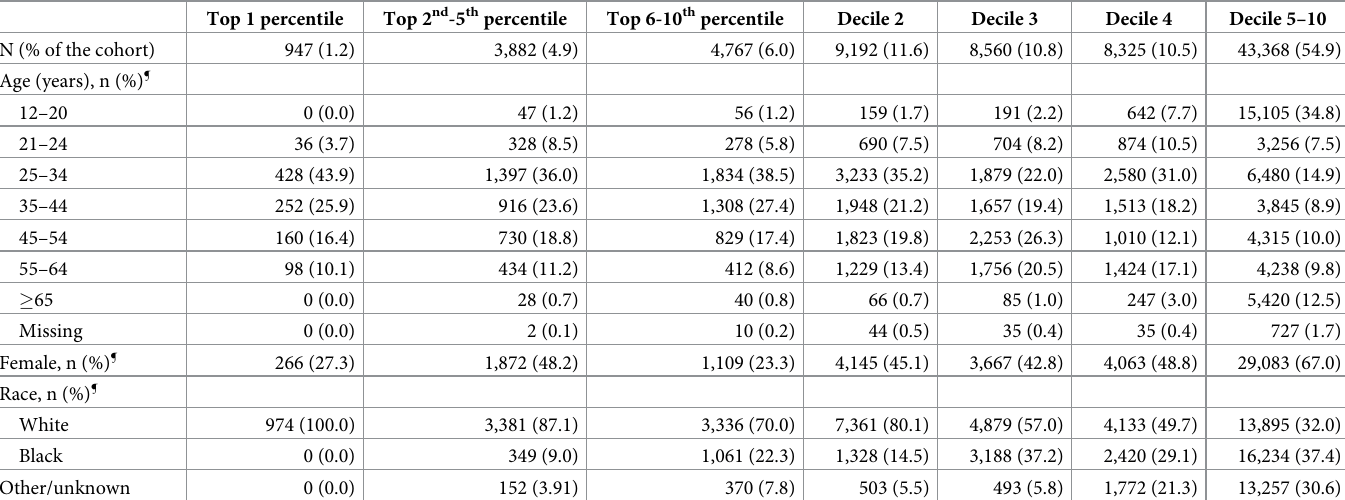
Table 2. Demographic profiles by risk subgroup in the gradient boosting machine model integrated model in the validation sample (n = 79,086).